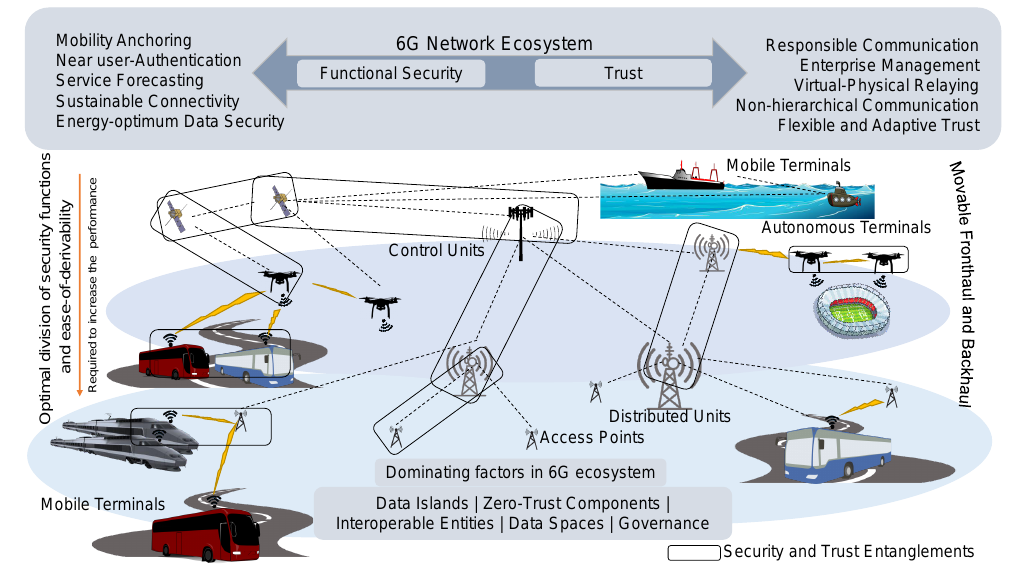
Figure 1. An exemplary illustration of the functional requirements of security and trust for 6G network